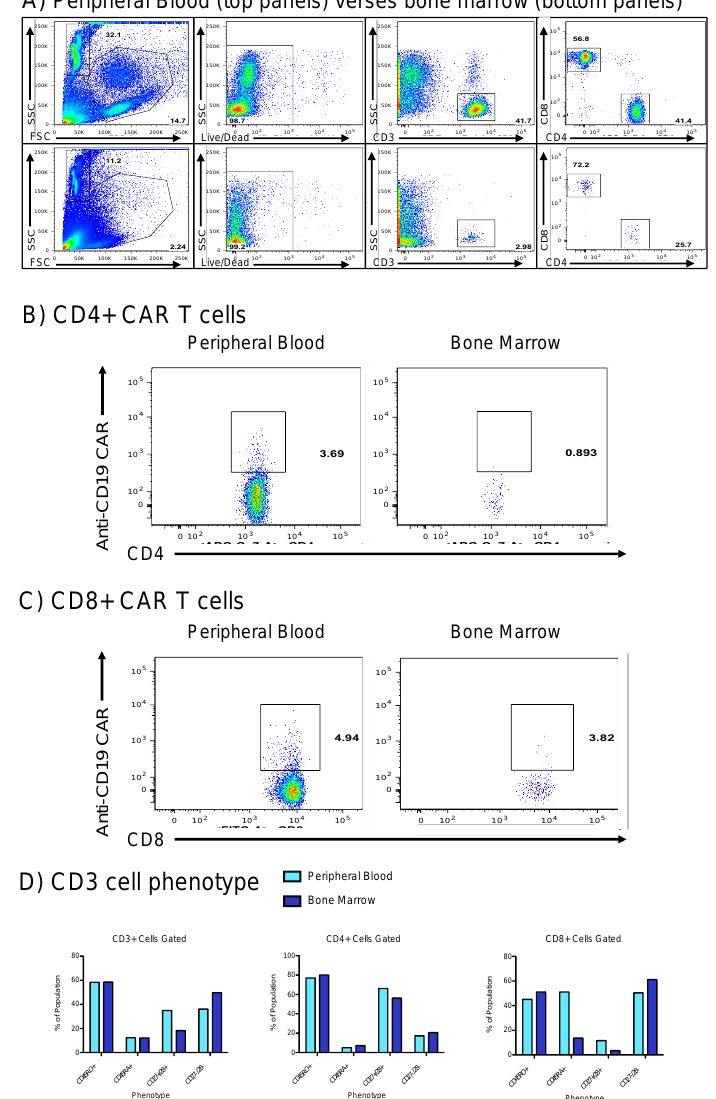
Figure 4. Comparison of bone marrow aspirates and peripheral blood during episode of pancytopenic aplasia. ( A ): Whole peripheral blood (top) was compared to bone marrow aspirates (bottom row) with qualitative finding of reduced marrow cellular content. ( B and C ): CD4+/CD8+ CAR T cells, respectably, were detectable in the peripheral blood and to a minimal extent in the marrow. ( D ): Comparison of memory/activated T cell (CD45RO+), naïve T cell (CD45RA+), and CD27/28 co-expression in bone marrow (dark blue) and peripheral blood (light blue).